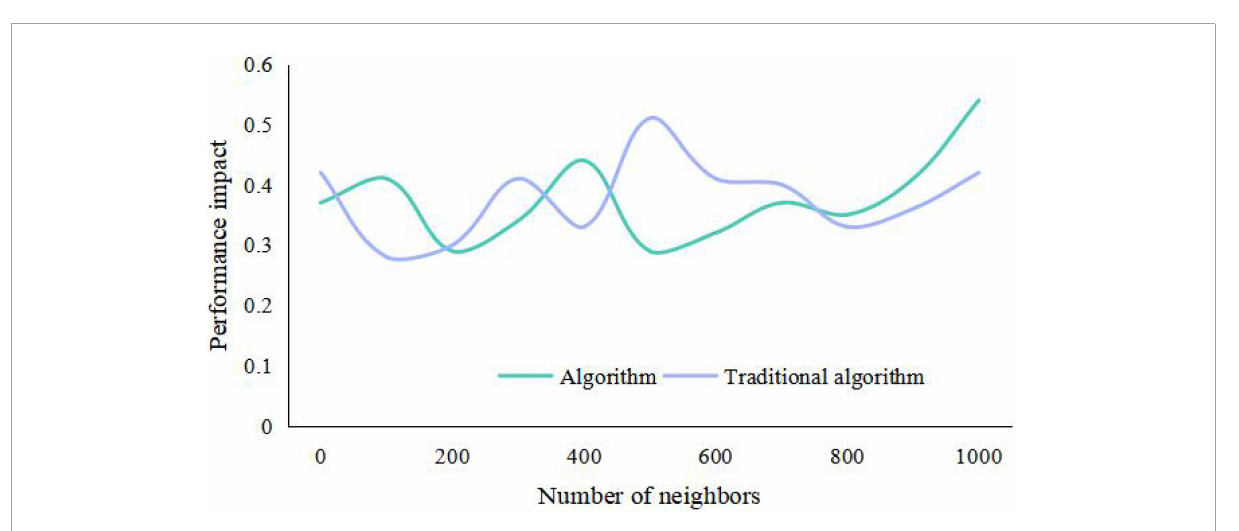
FIGURE3 Performance comparison chart.